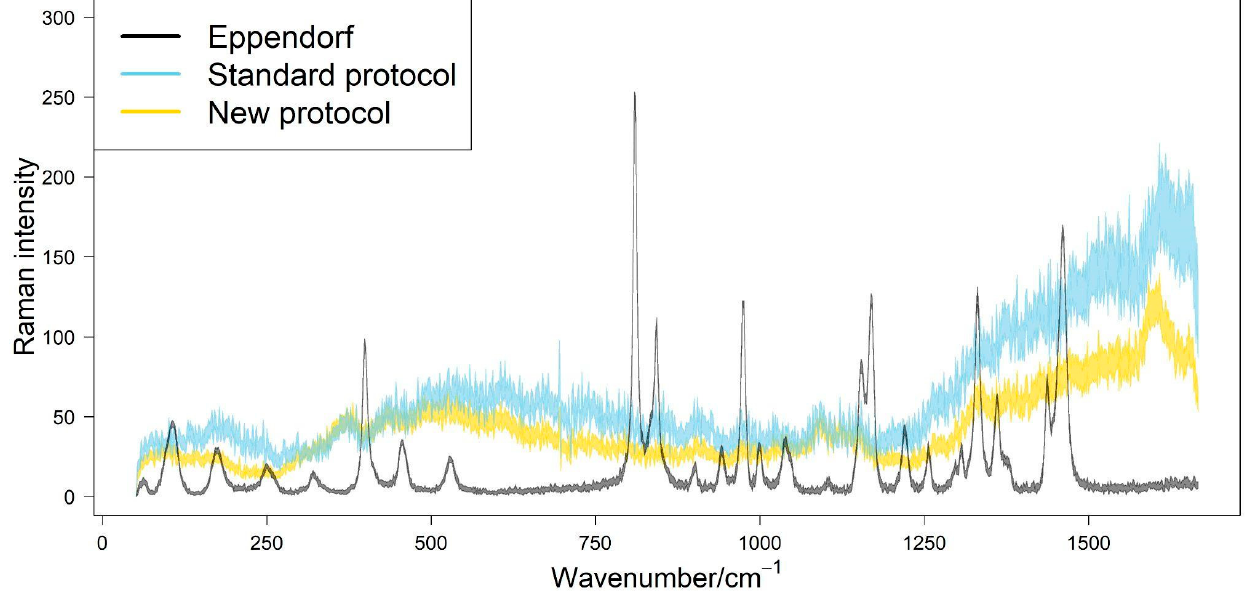
Figure 3. Comparison among Raman spectra of Eppendorf tubes (in grey) and wood milled with the two protocols (in colors). Each curve represents the confidence interval around the mean Raman spectra of Eppendorf tubes (in grey) and wood milled with the standard and new protocol (in light blue and yellow, respectively), over multiple Raman measures.